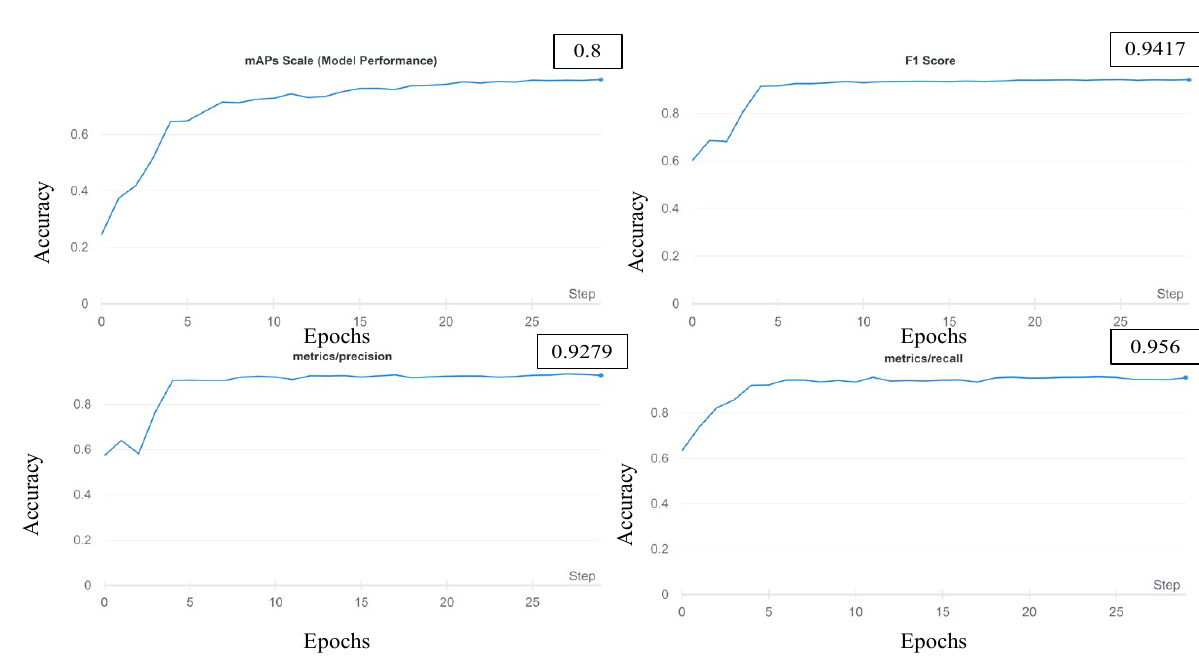
Figure 4. The results from the Detectron-2 training .